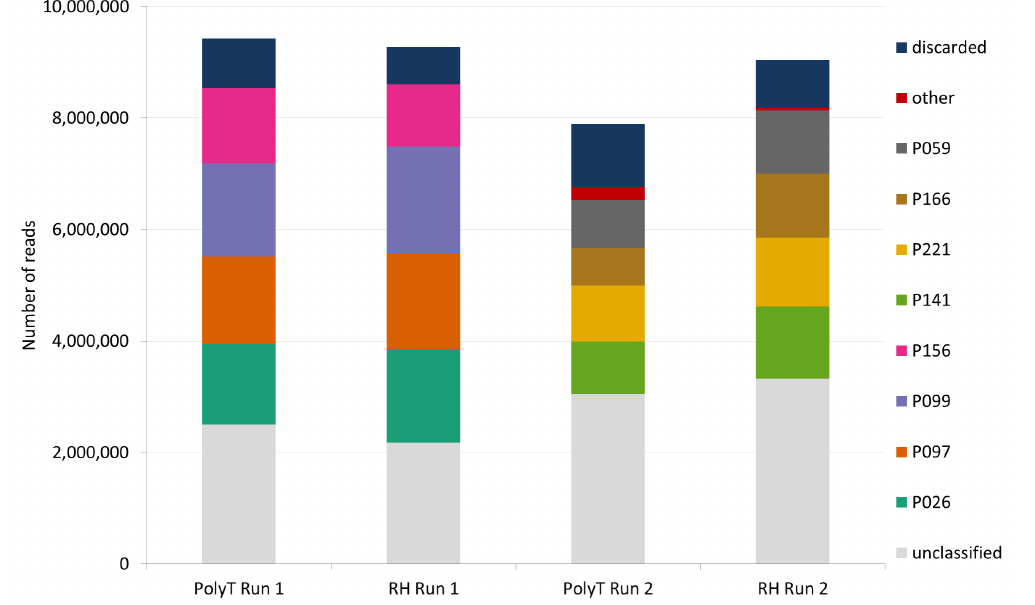
Figure 2. Sequencing yield in number of Oxford Nanopore Technologies (ONT) reads generated from each sequencing run, which passed the internal MinKnow filtering parameters (pass) and were further analyzed by Porechop for adapters trimming and barcode demultiplexing. Stacked bars are color coded according to Porechop analysis. A washing step was performed between two consecutive runs on the same flow cell (PolyT Run 1–2 and RH Run